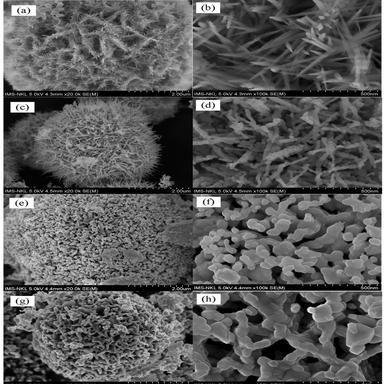
SEM images of (a, b) NiCoFe-LDH, and NiCoFe-LDO synthesized at (c, d) 500, (e, f) 600, and (g, h) 700 ◦C.